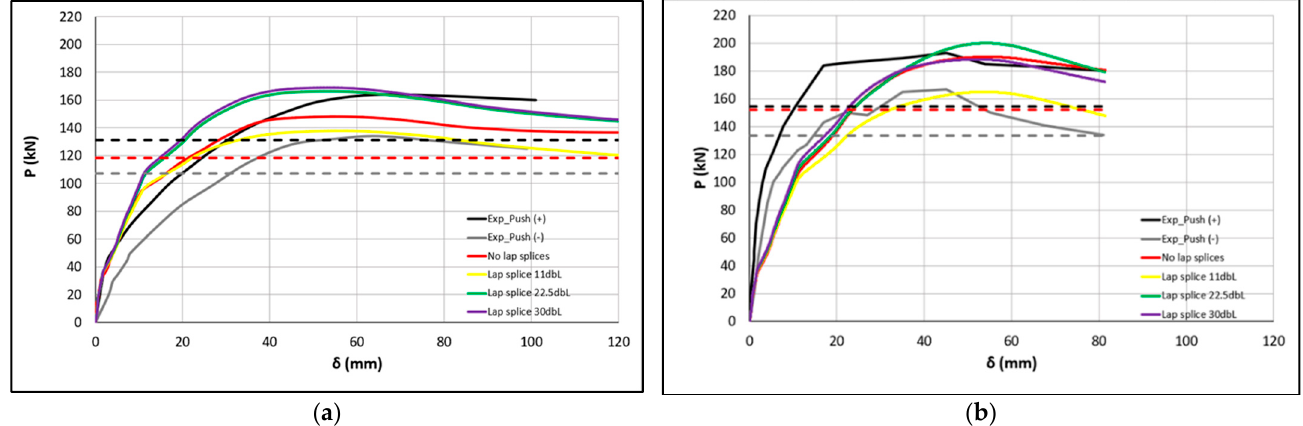
Figure 11. Analytical base shear force–displacement curve for ( a ) A1F (without infill) and ( b ) B2 (with infill), with different lap lengths, compared against the experimental ones.